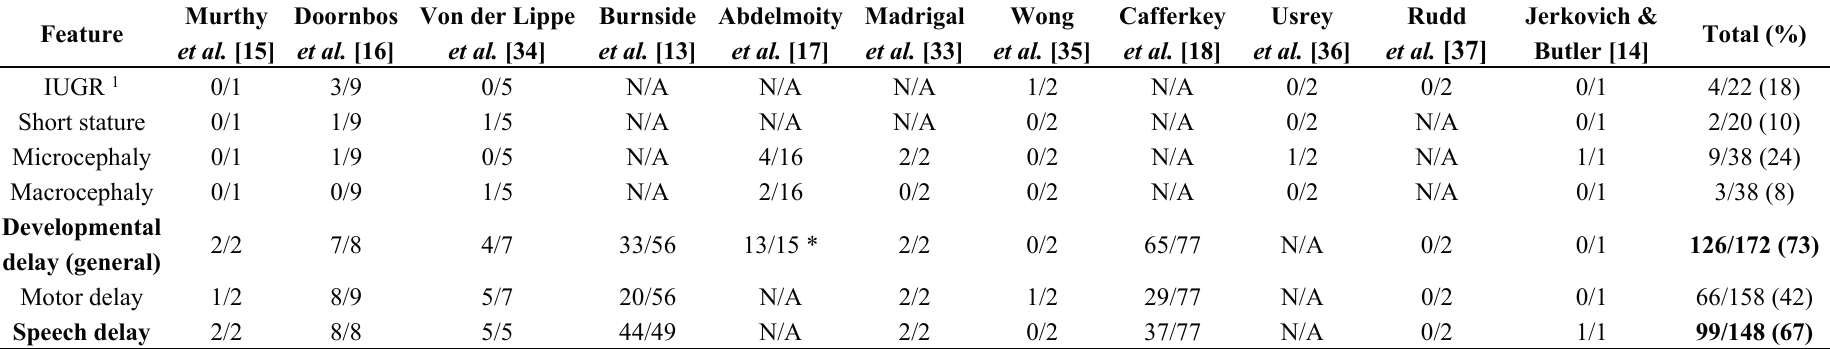
Table 1. Literature Review of Growth and Development for Individuals with Chromosome 15q11.2 BP1–BP2 Microdeletion Syndrome.